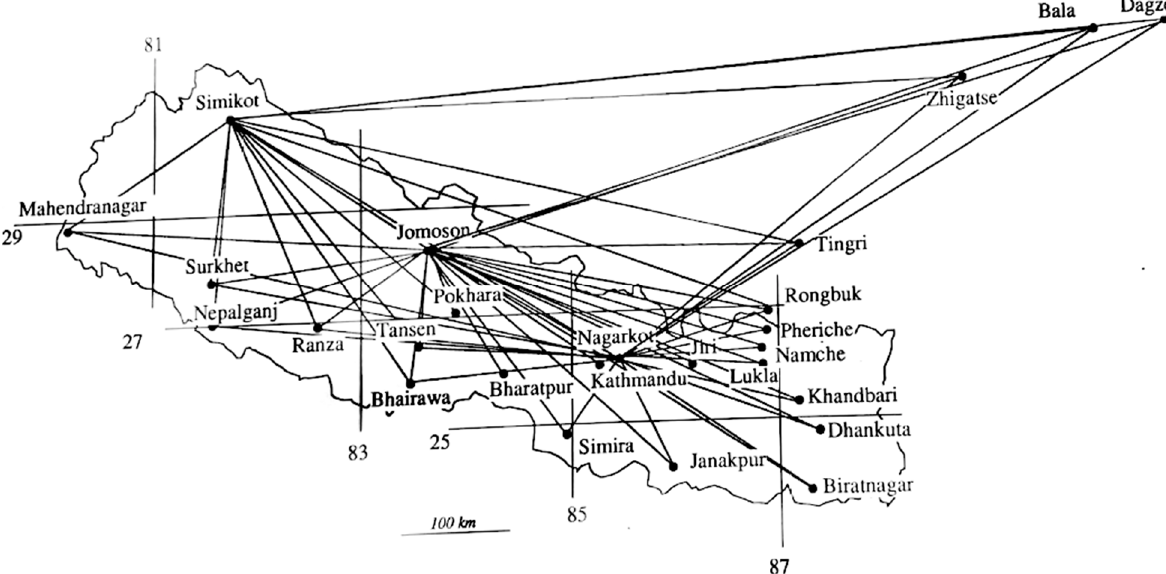
Figure 9. GPS control stations established during geodynamics study in 1991